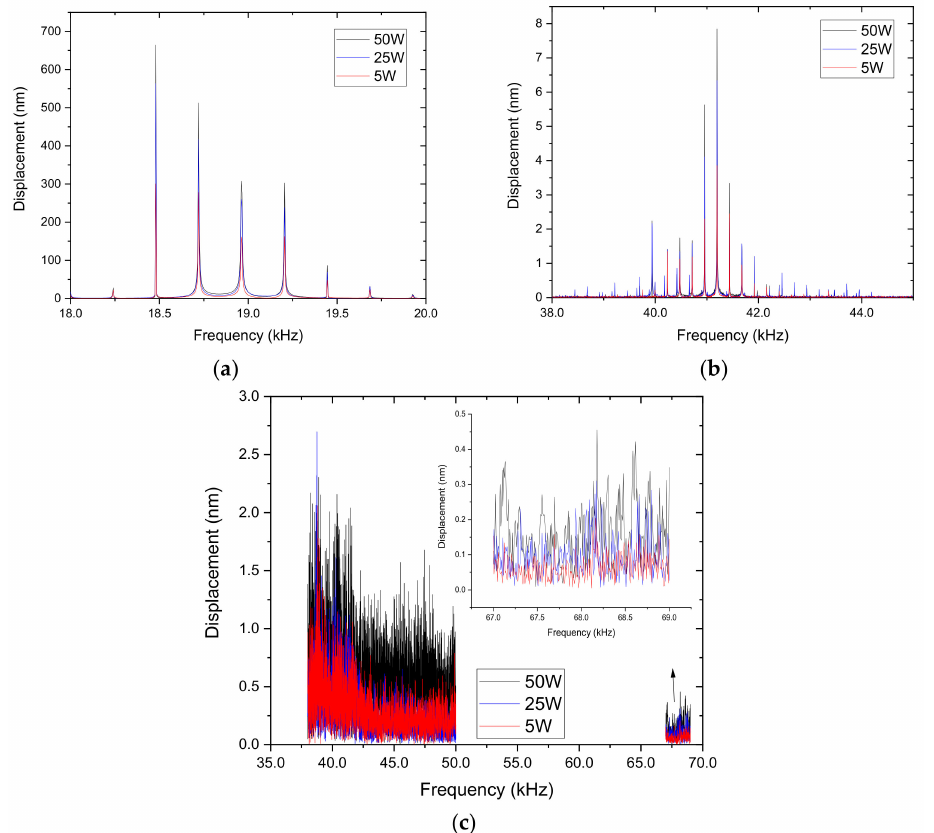
Figure 2. Vibrational response measured on the surface of the steel boxes with transducer nominal frequency of ( a ) 20 kHz, ( b ) 40 kHz, and ( c ) 68 kHz, under different input powers of 5, 25, and 50 W. The inset in (c) shows the magnified signals around 70